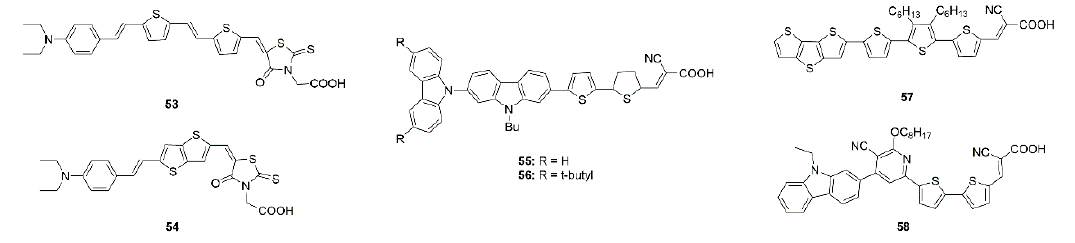
Figure 14. Chemical structures of dyes 53 – 58 .